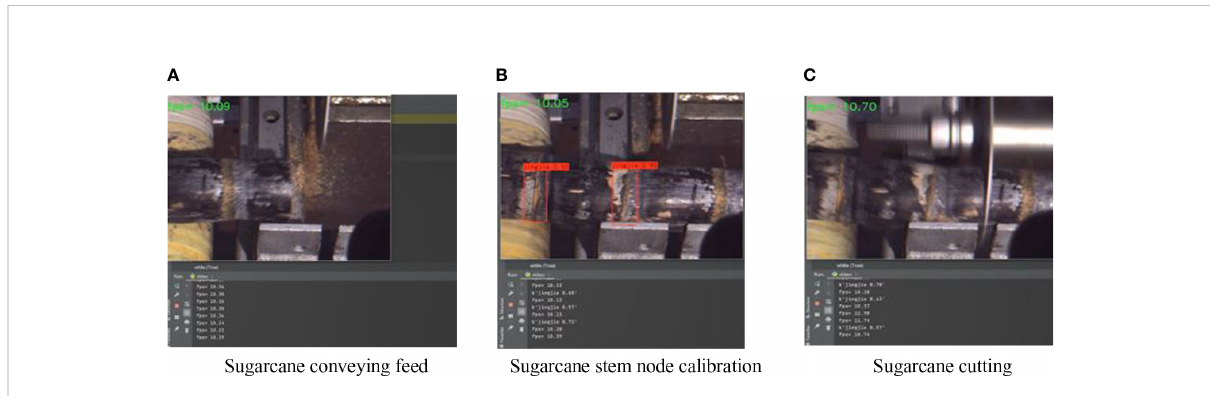
FIGURE 13 Sugarcane cutting test process. (A) Sugarcane conveying feed; (B) Sugarcane node calibration; (C) Sugarcane